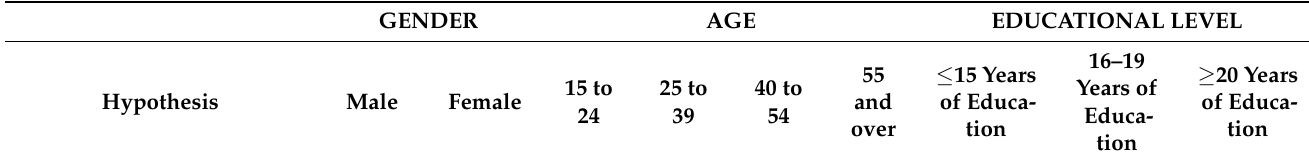
Table A3. Degree of fulfilment of the hypotheses for the gender, age, and educational level variables. GENDER AGE EDUCATIONAL